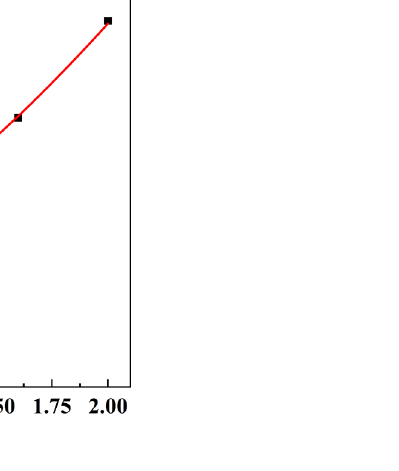
Figure 5. Explosive risk value of methane in